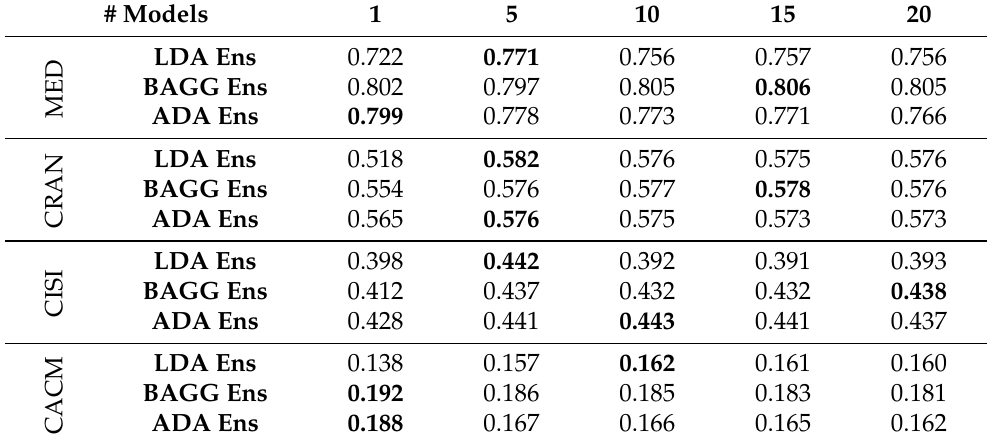
Table 2. Effect of the number of models in each ensemble strategy. Results are reported using MAP@10. The reported results consider the average between the five trials. Bold fonts indicate the best configurations. Differences between the number of models are statistically significant with 95% confidence according to the Wilcoxon test.